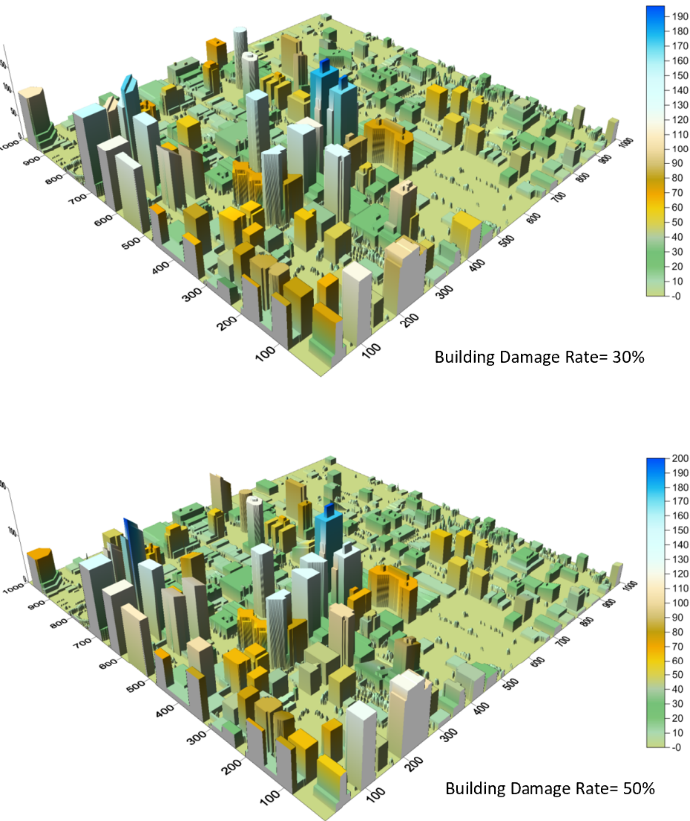
Figure 12. DSM maps of 30% ( upper ) and 50% ( lower ) damaged building areas with the same scenarios as those shown in Figure 11. The scales are in meters.